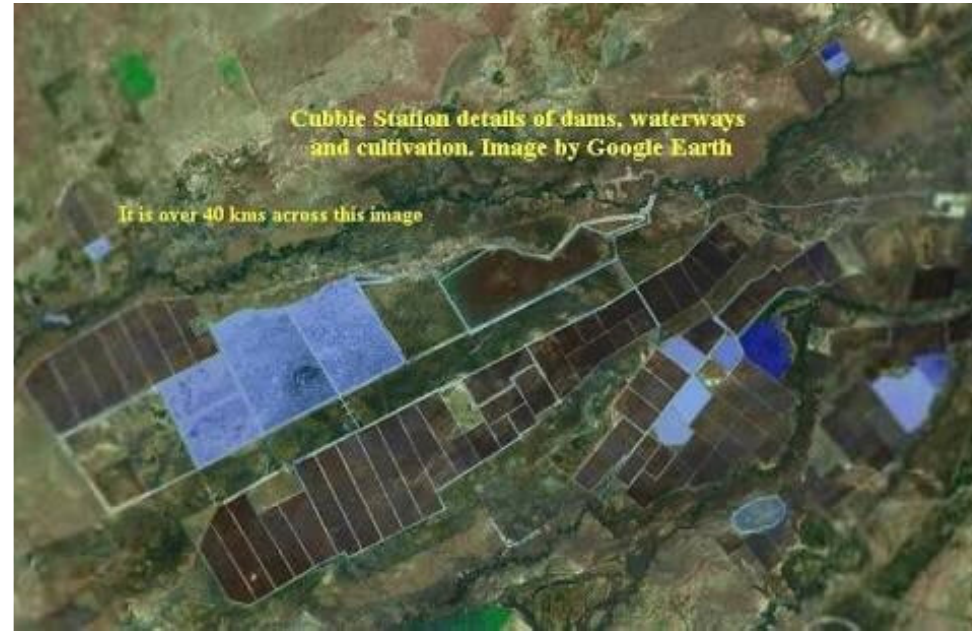
Figure 2. Aerial view of Cubbie Station. Google Earth.